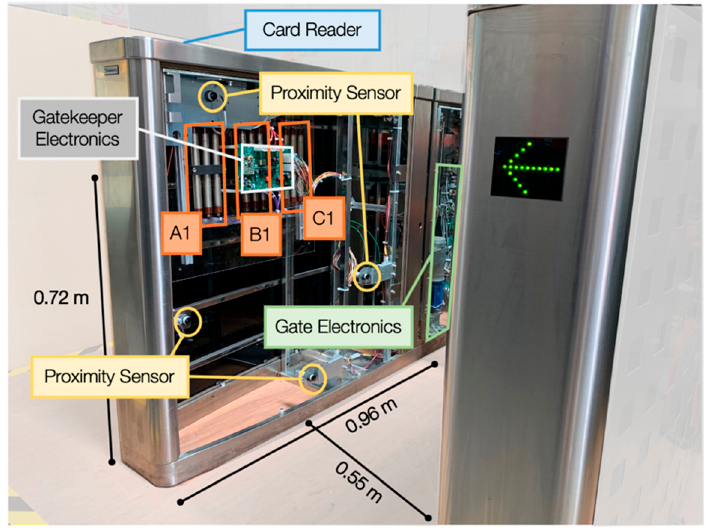
Figure 1. Photograph of the Gunnebo Speed Gate™ entrance control system containing the integrated radiation detection system comprising multiple Geiger–Muller detectors (A1, B1, C1), an array of offset proximity sensors and the single solid-state scintillator (spectroscopy) detector (not shown, on opposing side of Speed Gate™). The corresponding Geiger–Muller detectors (A2, B2, C2) are located directly opposite A1, B1 and C1 within the other upright section of the gate enclosure.